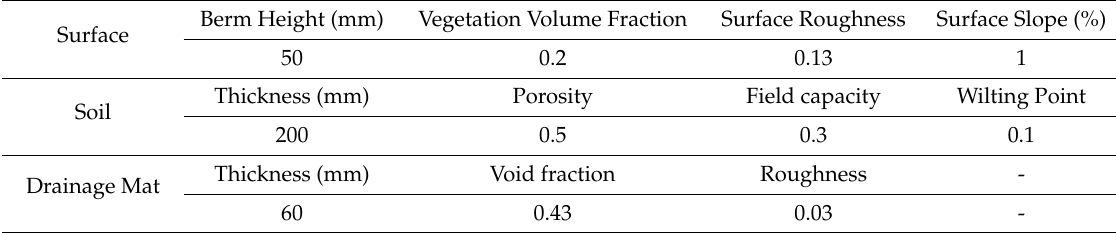
Table 1. Parameters of green roof in Storm Water Management Model (SWMM).